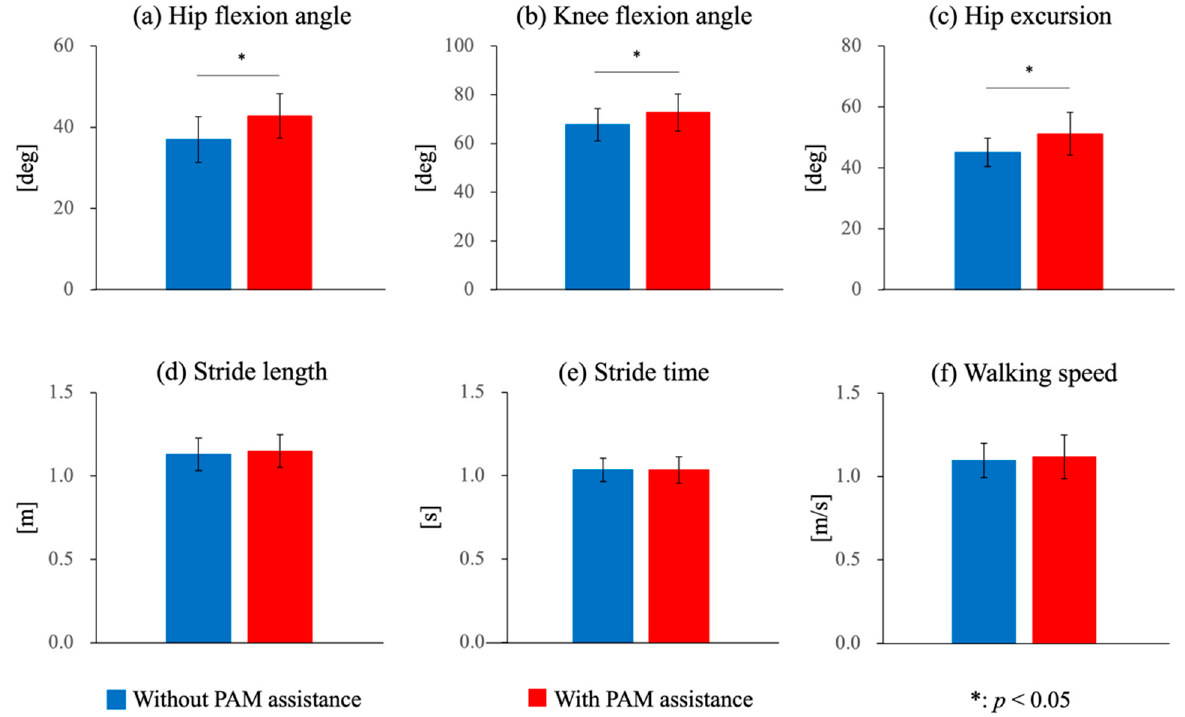
Figure 7. Differences in the hip and knee joint angles and performances between optimal pneumatic artificial muscle (PAM) assistance and lack of assistance.